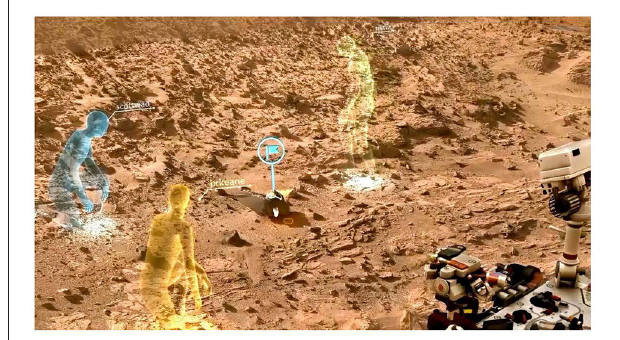
FIGURE 4 | OnSight used for visualization on the Mars Science Lab mission. Image credit: NASA/JPL-Caltech.